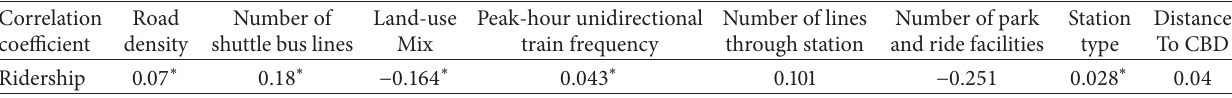
Table 2: Correlation analyses of nonpopulation variables and